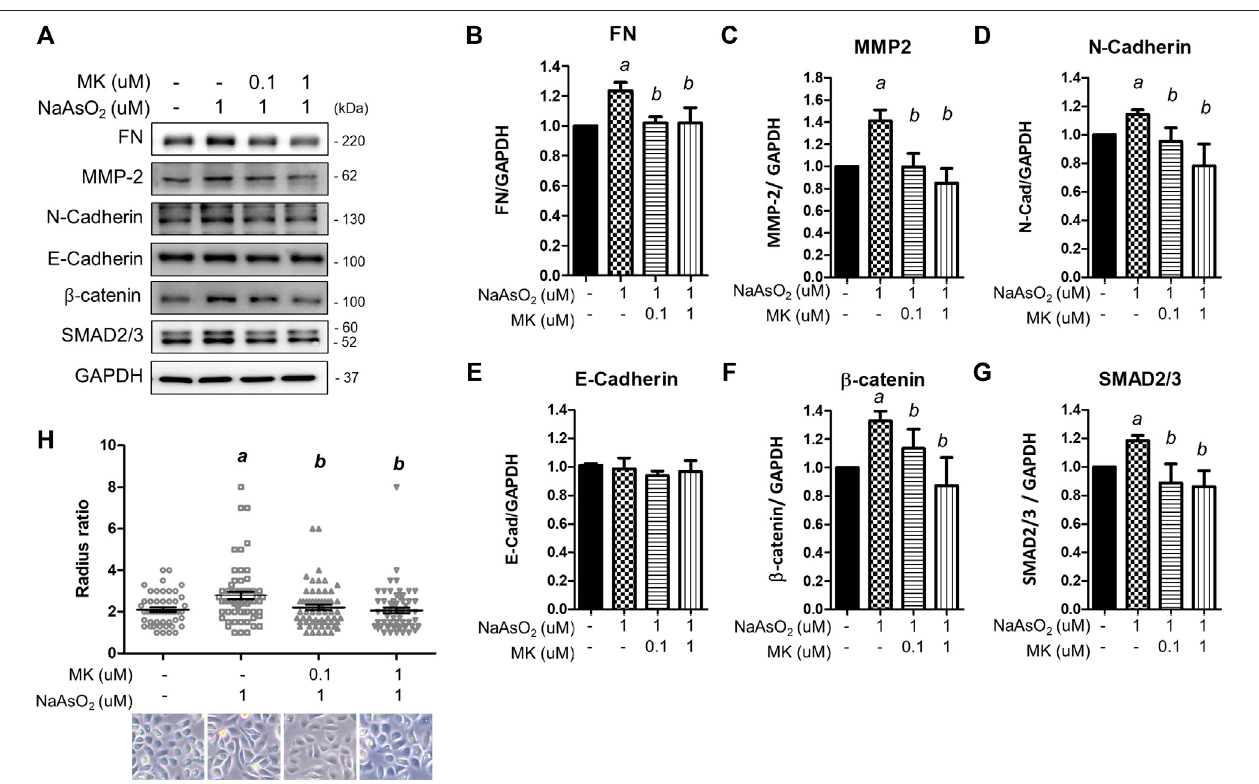
FIGURE 2 | The effect of montelukast on arsenic-induced EMT marker expression in NHBE cells. Cells were pretreated with montelukast for 2 h, followed by combinedtreatmentwith1 µMNaAsO 2 .After24 hoftreatment,thecellswereharvestedforproteinexpressionanalysisbywesternblotting. (A) Representativewestern blot images. (B – G) The quantitative results of protein expression changes are shown in (C – G) . a : p < 0.05 compared with the vehicle control group. b : p < 0.05 comparedwiththeNaAsO 2 group. (H) Thecellmorphologychanges.NHBEcellswerepretreatedwith0.1or1 µMmontelukastrespectivelyfor2 handfollowedby sodiumarseniteforanother48 h.Thecellmorphologywasanalyzedbyradius-ratiomethods. a : p < 0.05comparedwiththevehiclecontrolgroup. b : p < 0.05compared with the NaAsO 2